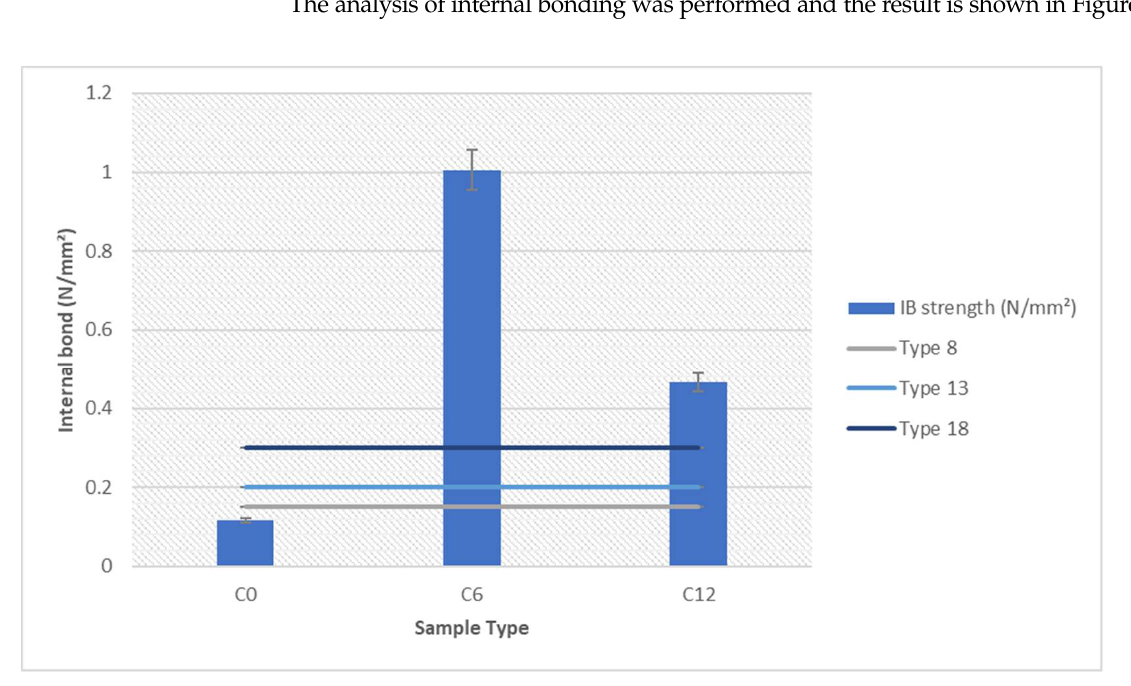
Figure 13. Internal bonding of soy-lignin bonded Rhizophora spp. particleboards at different percentages. C = 0 µm to 103 µm particle sizes; 0 = 0% soy flour and lignin, 6 = 4.5% soy flour and 1.5% lignin, 12 = 9% soy flour and 3% lignin.